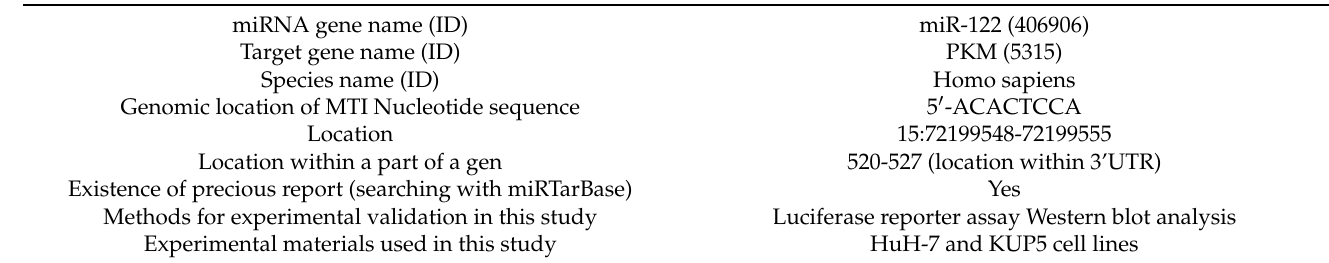
Table 1. Validations of microRNA (miRNA) used in this study.